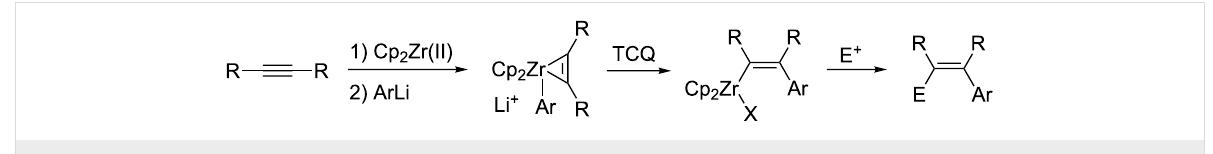
Scheme 3: TCQ-promoted reductive elimination of arylzirconate.